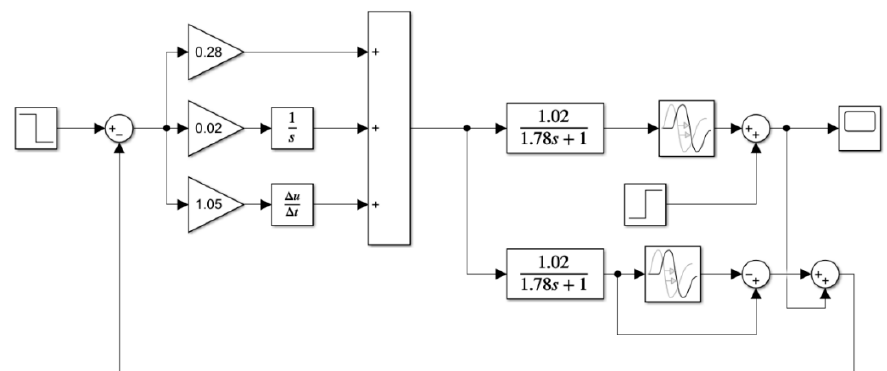
Figure 5. Simulation model of pH regulation system based on Smith’s prediction compensation.